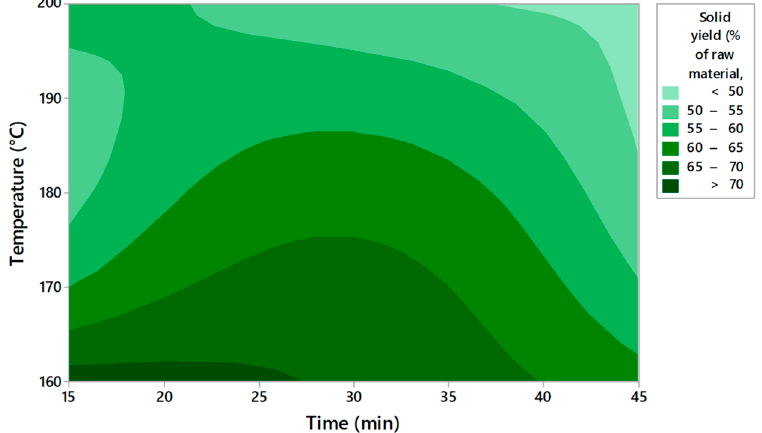
Figure 1. Contour plots of solid yield depending on time and temperature.